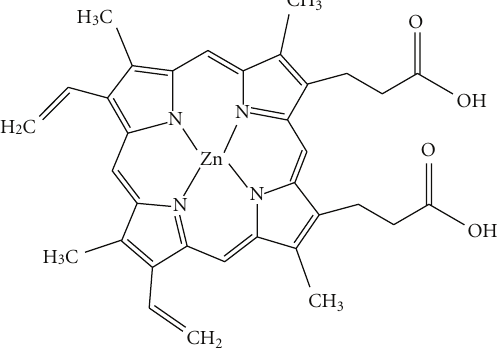
Scheme 1: Structure of ZnPP.